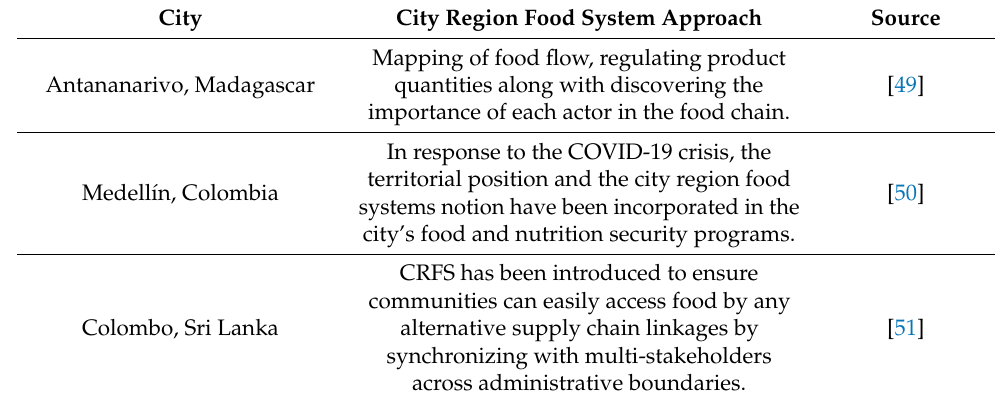
Table 1. Examples of city–region food system approaches in response to